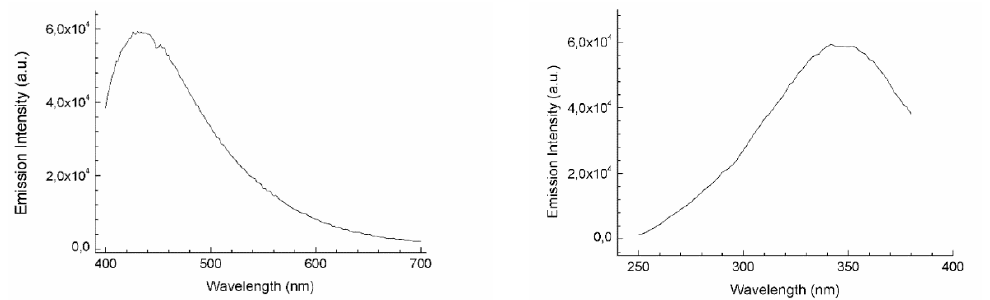
Figure 1. ( left ) Emission and ( right ) excitation profiles of untreated cotton textile.